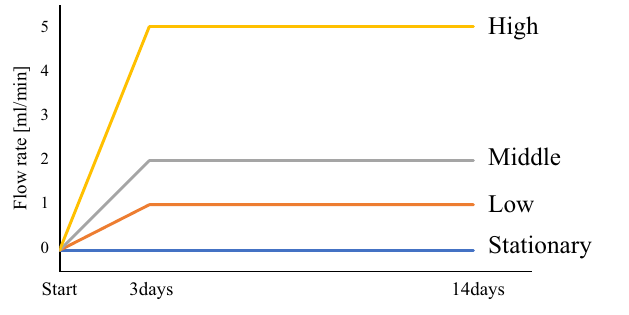
Figure 16. Training flow